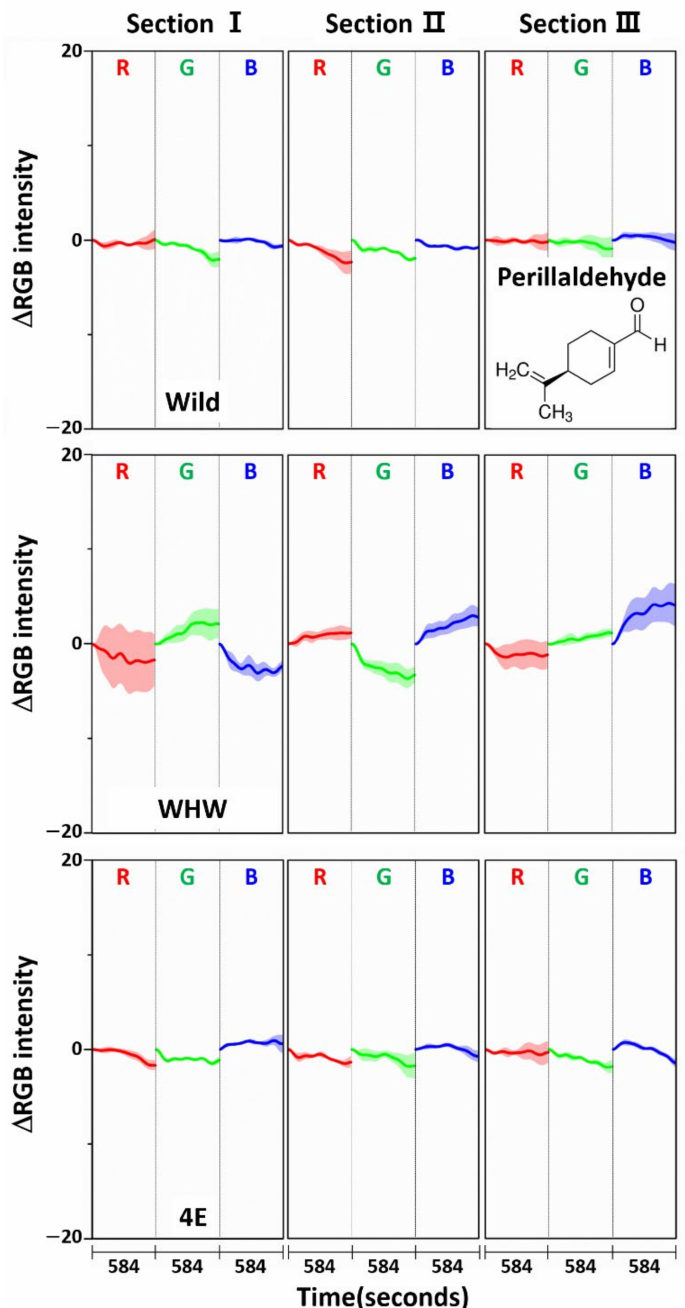
Figure 11. Average ∆ RGB intensity of perillaldehyde individually acquired using Wild, WHW, and 4E sensors. The molecular structure of perillaldehyde is also